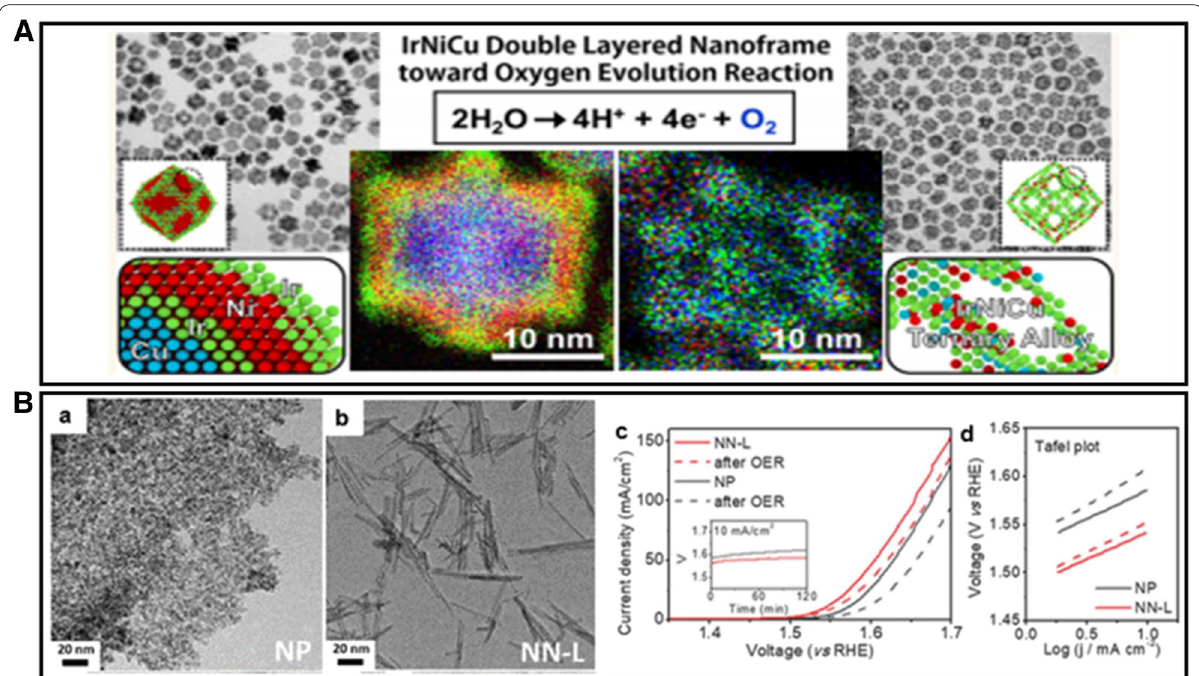
Fig. 12 A The HAADF‑STEM, TEM, HRTEM, and elemental mapping of desired IrNiCu DNF structure (Figure reprinted with permission from Ref. [60]). B (a, b) TEM images of IrO 2 nanoparticles and IrO 2 nanoneedles, (c, d) OER performance before and after 2 h galvanostatic operation, (c) LSV curves of IrO 2 NN and unshaped nanoparticles, (d) Tafel slope (Figure reprinted with permission from Ref.